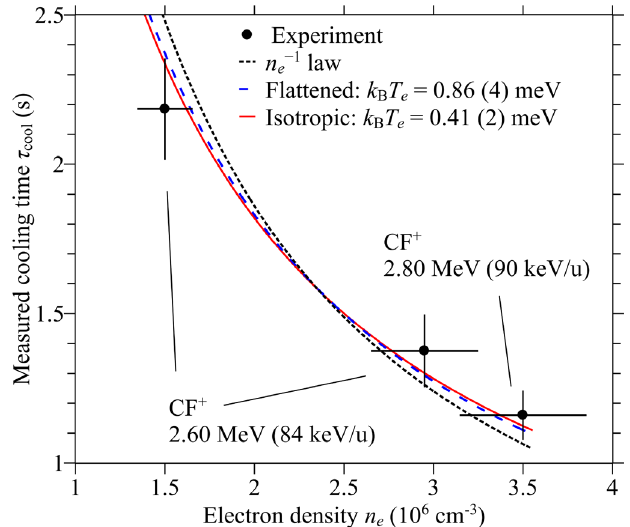
FIG. 5. Measured transverse cooling times τ ¼ 31 u) as a function of the electron density n CF þ ( m i short-dashed black curve is a simplified 1 =n e -dependence as in Eq. (12). The other curves are fits of Eq. (11) using the cooling rates λ from Eqs. (9) (long-dashed blue) and (8) (solid red), respectively, thus taking the density- and temperature-dependence of L C into